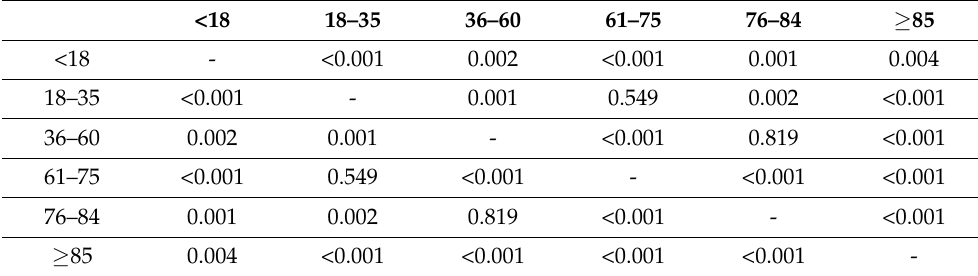
Table 2. Difference in nasal decongestant consumption by age groups.